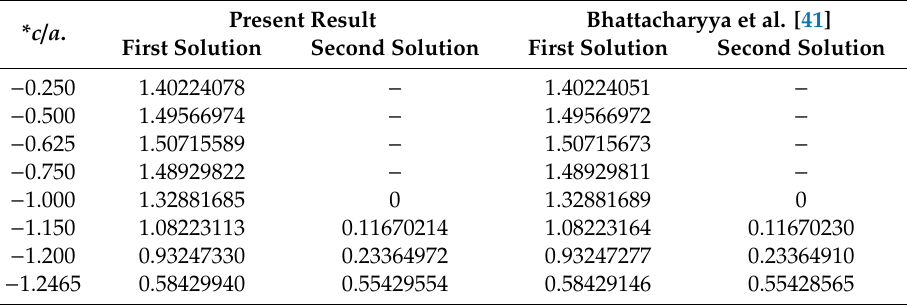
Table 2. Numerical validation of f (cid:48)(cid:48) ( 0 ) when S = 0 in [41]. * c / a